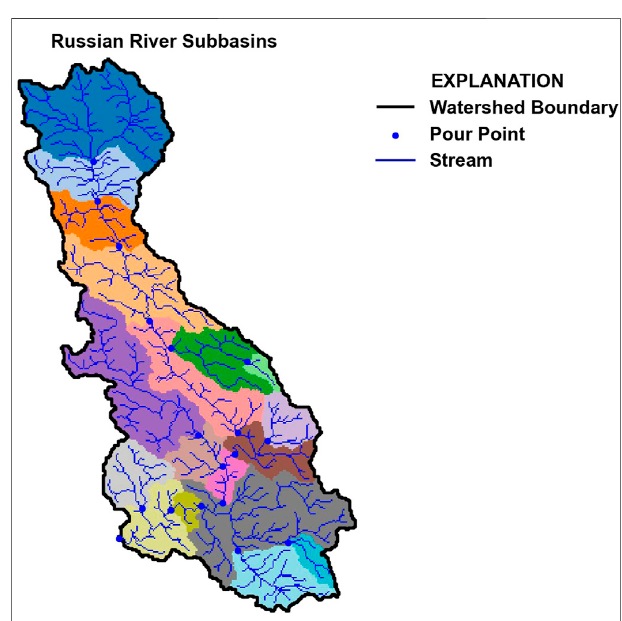
FIGURE 4 | Watershed and subbasin delineation results for the Russian River watershed. U.S. Geological Survey streamgages (U.S. Geological Survey, 2021) were supplied to the script as pour points for watershed and subbasin delineation. The black outline represents the Russian River watershed, and unique colors represent individual subbasins calculated by pyGSFLOW. Blue lines show the stream network generated from 1 Arc- second (27.28 m) digital elevation data (U.S. Geological Survey, 2020) by pyGSFLOW, Russian River watershed, northwestern California.